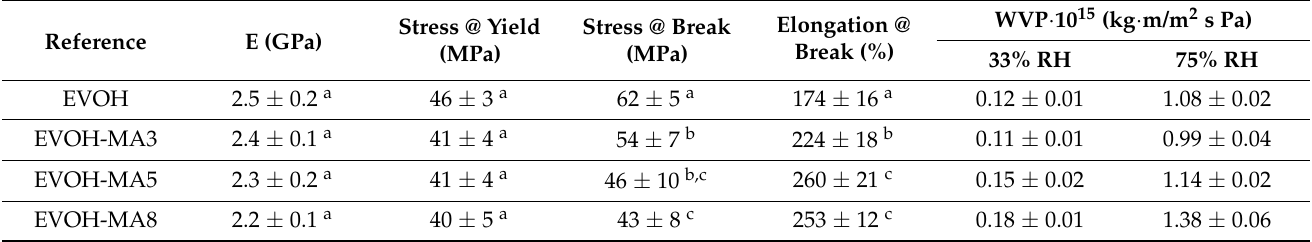
Table 3. Mechanical properties and water vapor permeability values of EVOH-based films.